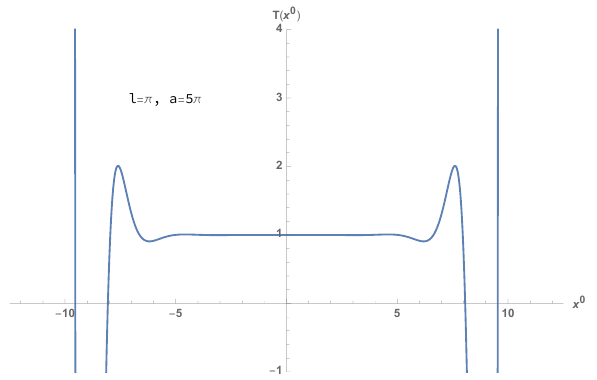
Figure 24 . Time evolution of the tachyon in the toy model for a periodic array of D-branes localized in imaginary time at x 0 = ia